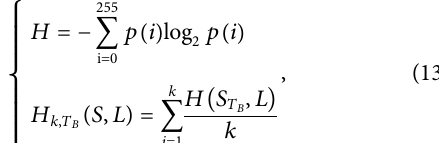
TABLE 6 | Differential attack test results. Image